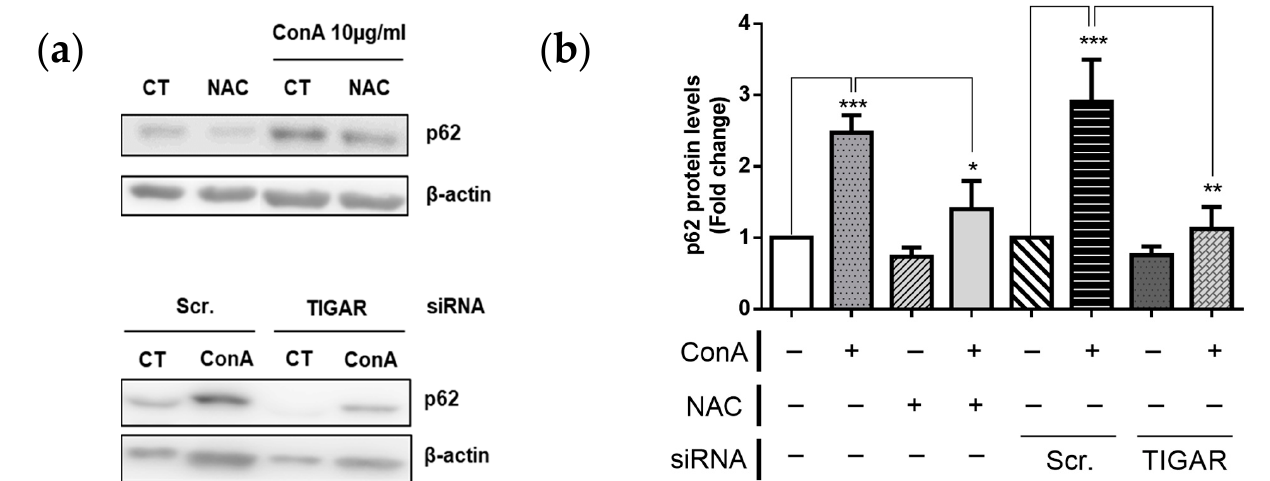
Figure 6. p62 protein expression in human ConA-stimulated lymphocytes after TIGAR depletion. ( a ) Western blot analysis of p62 protein levels normalized to β -actin in 10 µ g/mL in ConA-treated and untreated (Ct) T lymphocytes ± NAC and siRNA-treated T lymphocytes. Representative Western blot images are shown. ( b ) All data are presented as the mean fold change relative to untreated cells ± SEM. Differences were calculated with two-way ANOVA and Tukey’s multiple comparisons test with a normal-based 95% CI. Significant p values are indicated; * p < 0.05; ** p < 0.01; *** p < 0.001; n =